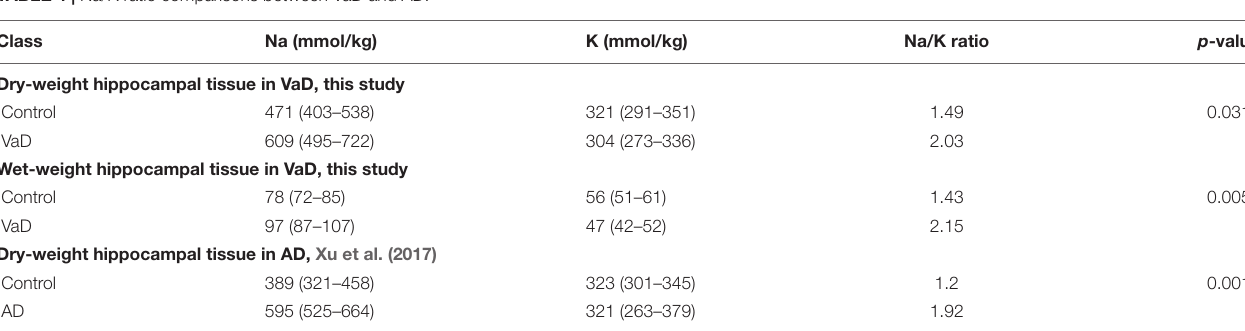
TABLE 4 | Na/K ratio comparisons between VaD and